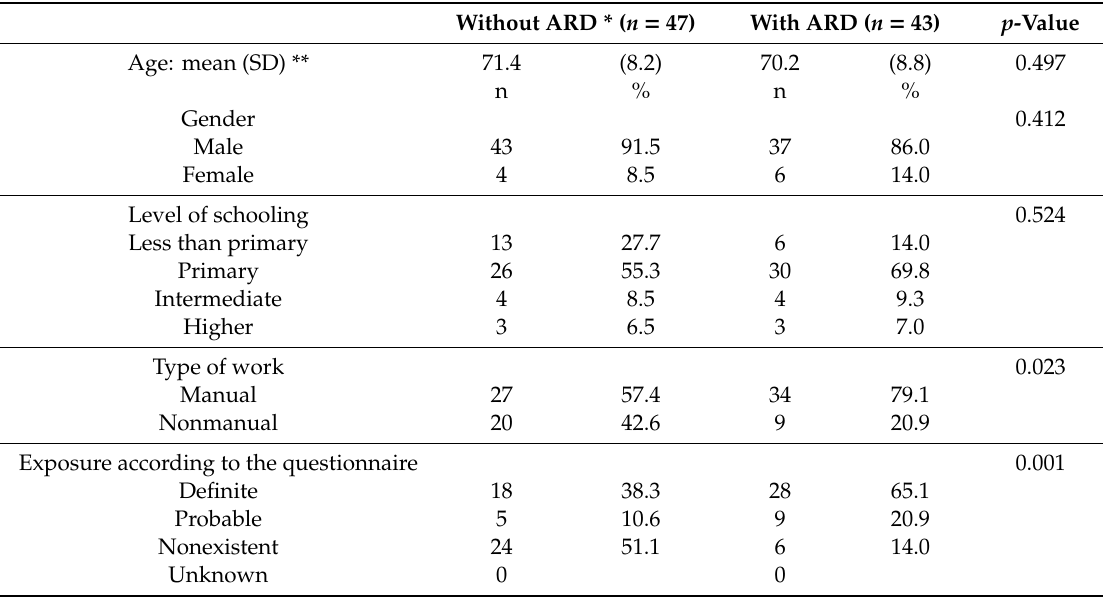
Table 1. Description of study participants and results for occupational exposure to asbestos according to the QEAS-7